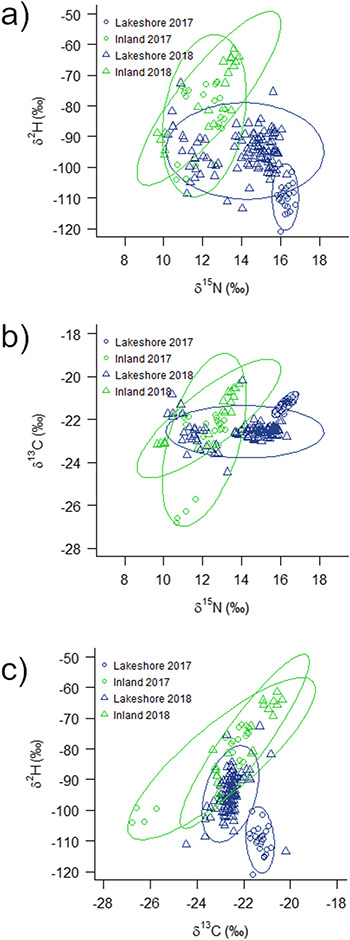
Biplots of juvenile Bank Swallow feather (a) δ2Hf versus δ15Nf, (b) δ13Cf versus δ15Nf and (c) δ2Hf versus δ13Cf (‰) for lakeshore (n = 131) and inland (n = 43) sites in 2017 (n = 47) and 2018 (n = 127). Bayesian ellipses were grouped by habitat and year at 95% confidence interval.